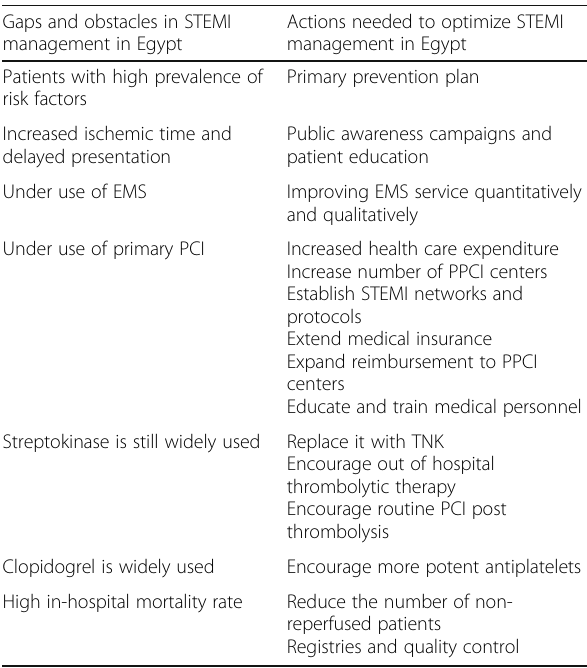
Table 4 Summary of possible gaps and obstacles and the suggested actions needed to improve STEMI management in Egypt Gaps and obstacles in STEMI management in